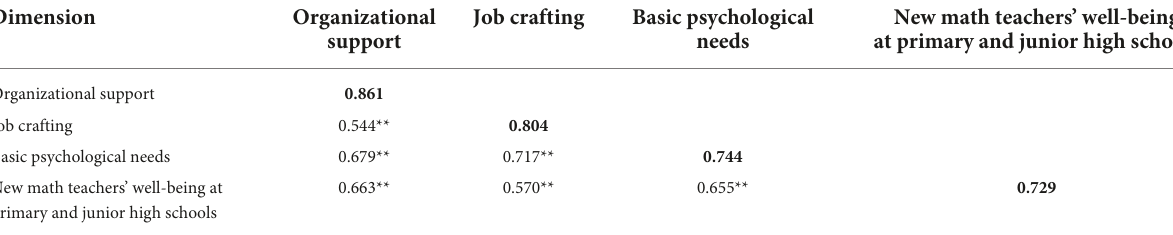
TABLE 3 Discriminant validity